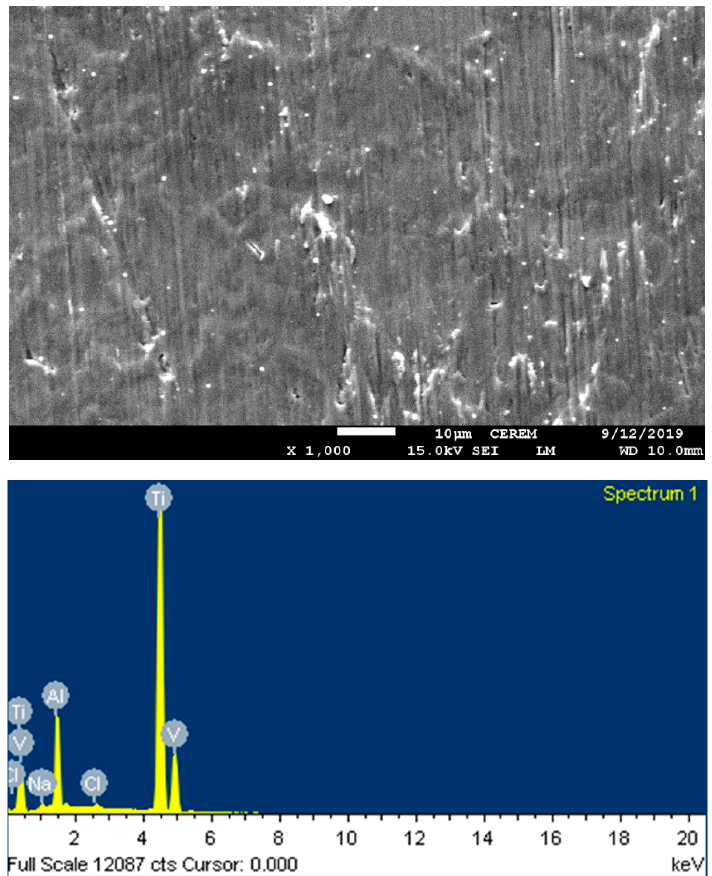
Figure 12. SEM micrograph and EDX spectrum obtained for Ti6Al8V alloy after its immersion for 48 h